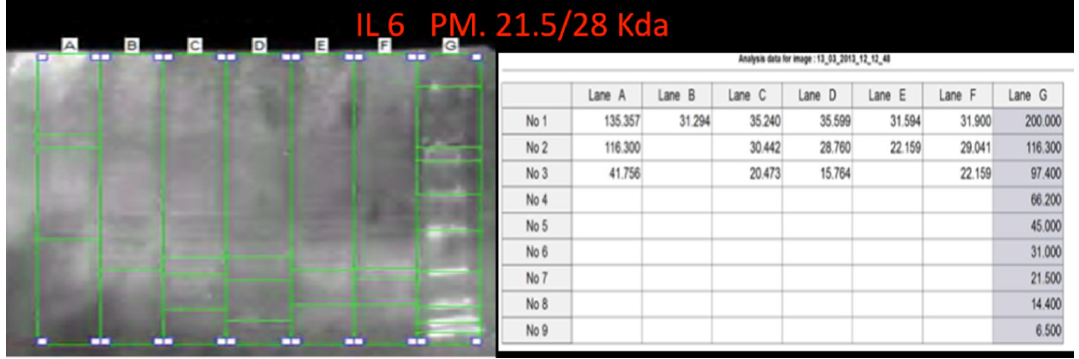
Figure 9. IL-6 representative blot and quantitative expression. On the right side representative blot ( upper ) and quantitative expression ( lower ). Marker’s lines on the right side of the blot